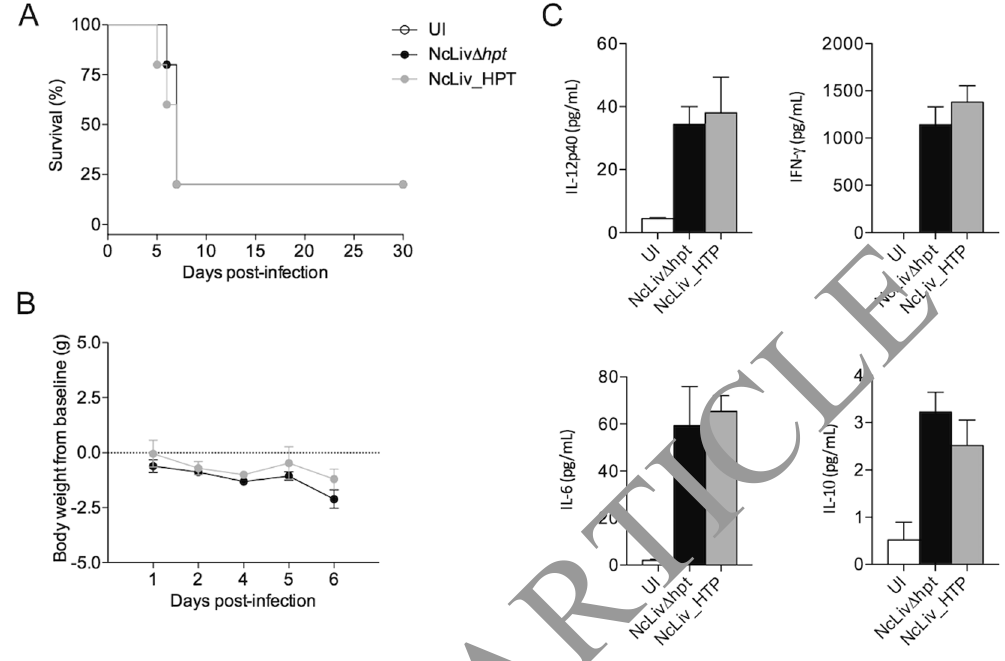
Figure 1. C57BL/6 mice infected by NcLiv ∆ hpt and the complemented strain present similar virulence and cytokine profiles in vivo . C57BL/6 mice were infected with 1 × 10 6 tachyzoites of NcLiv Δ hpt and NcLiv_HPT for 3 days for cytokine measurement or 30 days for survival analysis. As negative controls, mice were inoculated with PBS (uninfected - UI). ( A ) Survival curves and ( B ) Body weight from baseline of C57BL/6 mice after infection with N. caninum , ( C ) Cytokine production in the peritoneal wash (6 mice/group) after 3 days of infection measured by CBA. Values are representative of two independent experiments, indicating mean ± SEM of cytokine levels in relation the standard curve ( * P < 0.05; ANOVA and Bonferroni multiple comparison